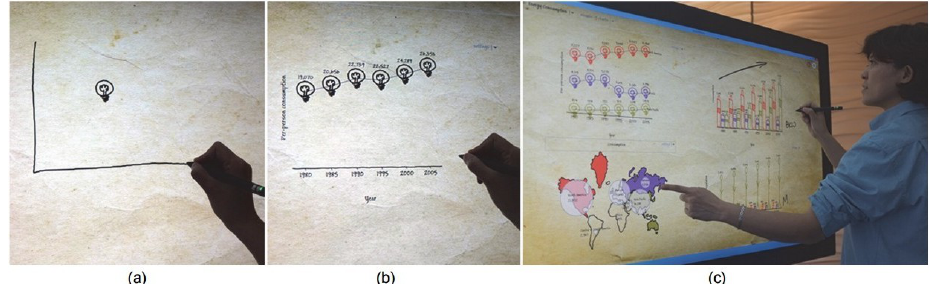
Figure 8. Lee et al. show an example of SketchStory in information visualization presentation [22]. ( a ) A presenter sketches out a chart axis; ( b ) SketchStory completes the chart; ( c ) The presenter interacts with the charts. Image courtesy of Lee et al.